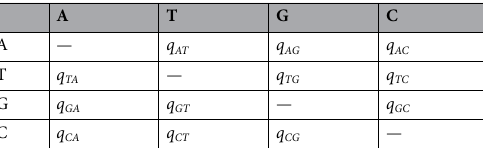
Table 3. Substitution rate matrix Q for the unrestricted model of nucleotide substitutions (UNREST). The diagonals of Q are determined to each row sum up to 0. The nucleotide stationary distribution π = ( π A , π T , π G , π C ) is given by the set of equations